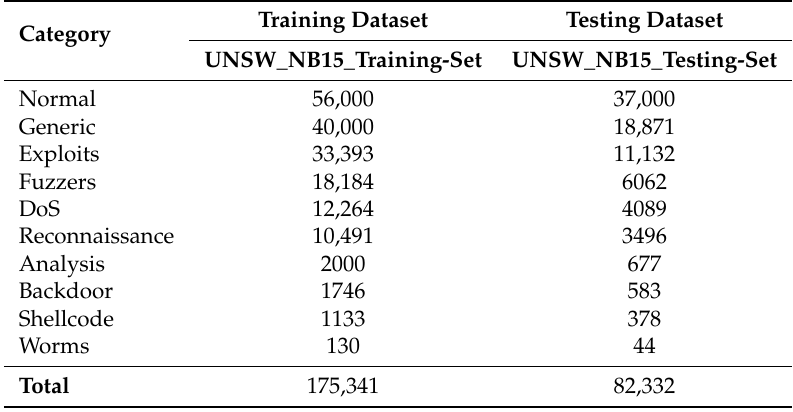
Table 3. The class distribution of the UNSW-NB15